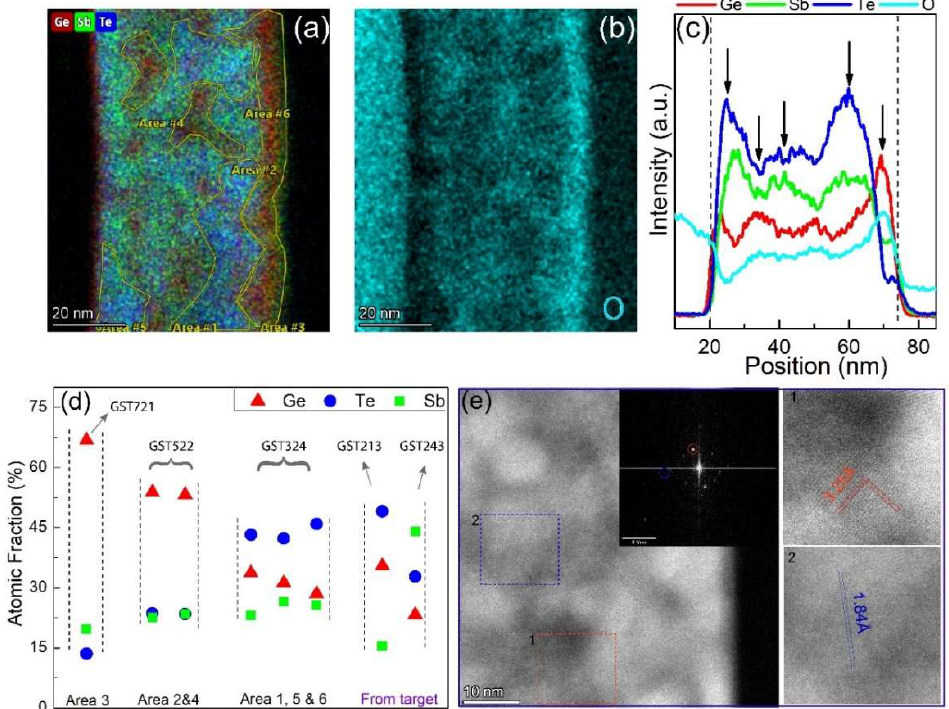
Figure 5. ( a ) The combined (Ge, Sb, and Te) STEM-EDX chemical mapping of the Ge-rich GST sample. Based on color contrast, multiple areas are selected for local composition analysis. The EDX chemical composition of oxygen is given in ( b ). ( c ) The line profile of the combined and the oxygen STEM-EDX chemical mapping of the Ge-rich GST sample. The oxygen line profile is scaled for better comparison with the Ge line profile. ( d ) Atomic fraction (in at.%) of the individual selected areas in ( a ) are plotted and compared with the atomic fraction from the melted target. ( e ) High-resolution images of some grains in the annealed sample with the inset showing the FFT.